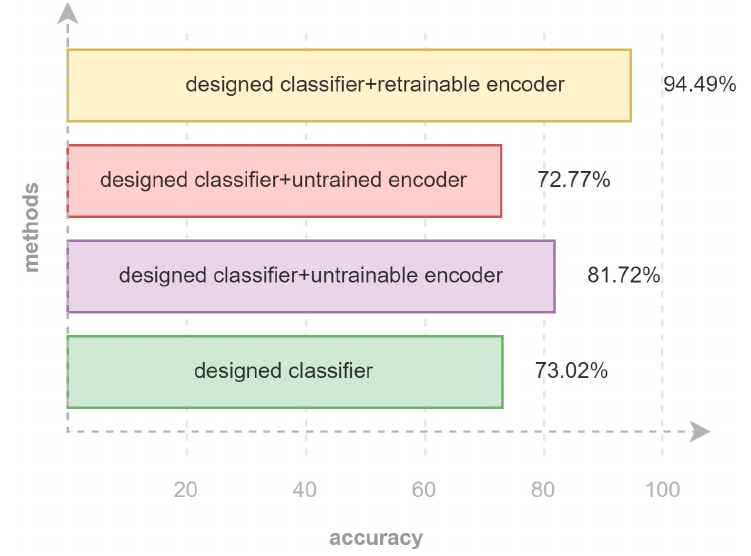
Figure 12. Accuracy of different methods that include MIMO-AE and without autoencoder, imple- mented on 50% of the training dataset.